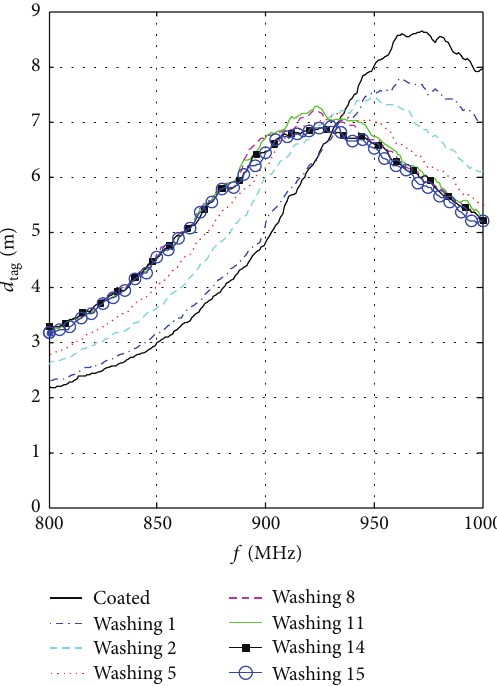
Figure 6: Measurement results for a tag that is working well after 15 washing